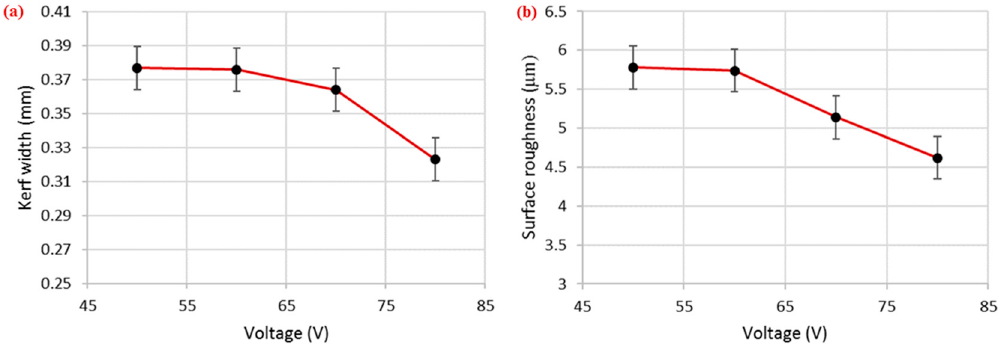
Figure 5. Effect of voltage on ( a ) kerf width and ( b ) surface roughness.